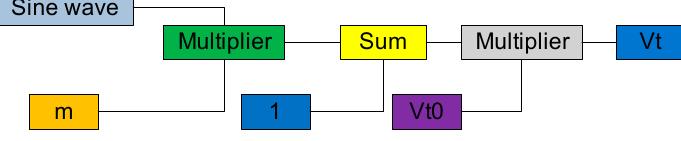
Figure 7. Flicker generation.